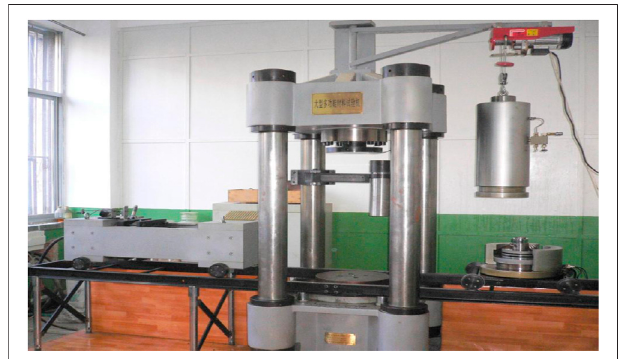
FIGURE 1 | WDT-1500 testing